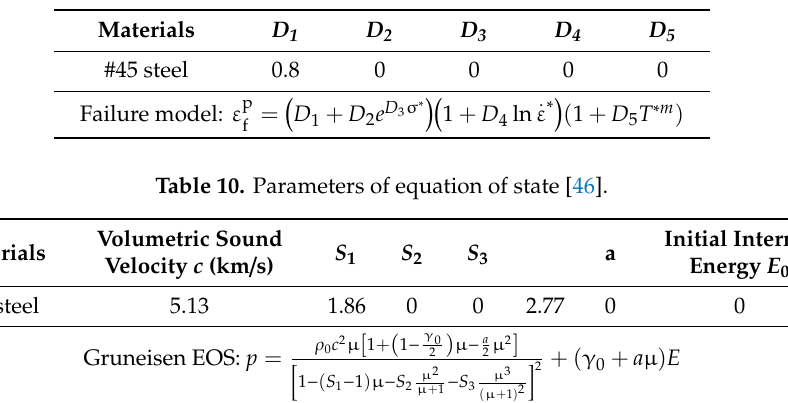
Table 8. Parameters of the constitutive model [46]. Table 9. Parameters of the failure model [46].